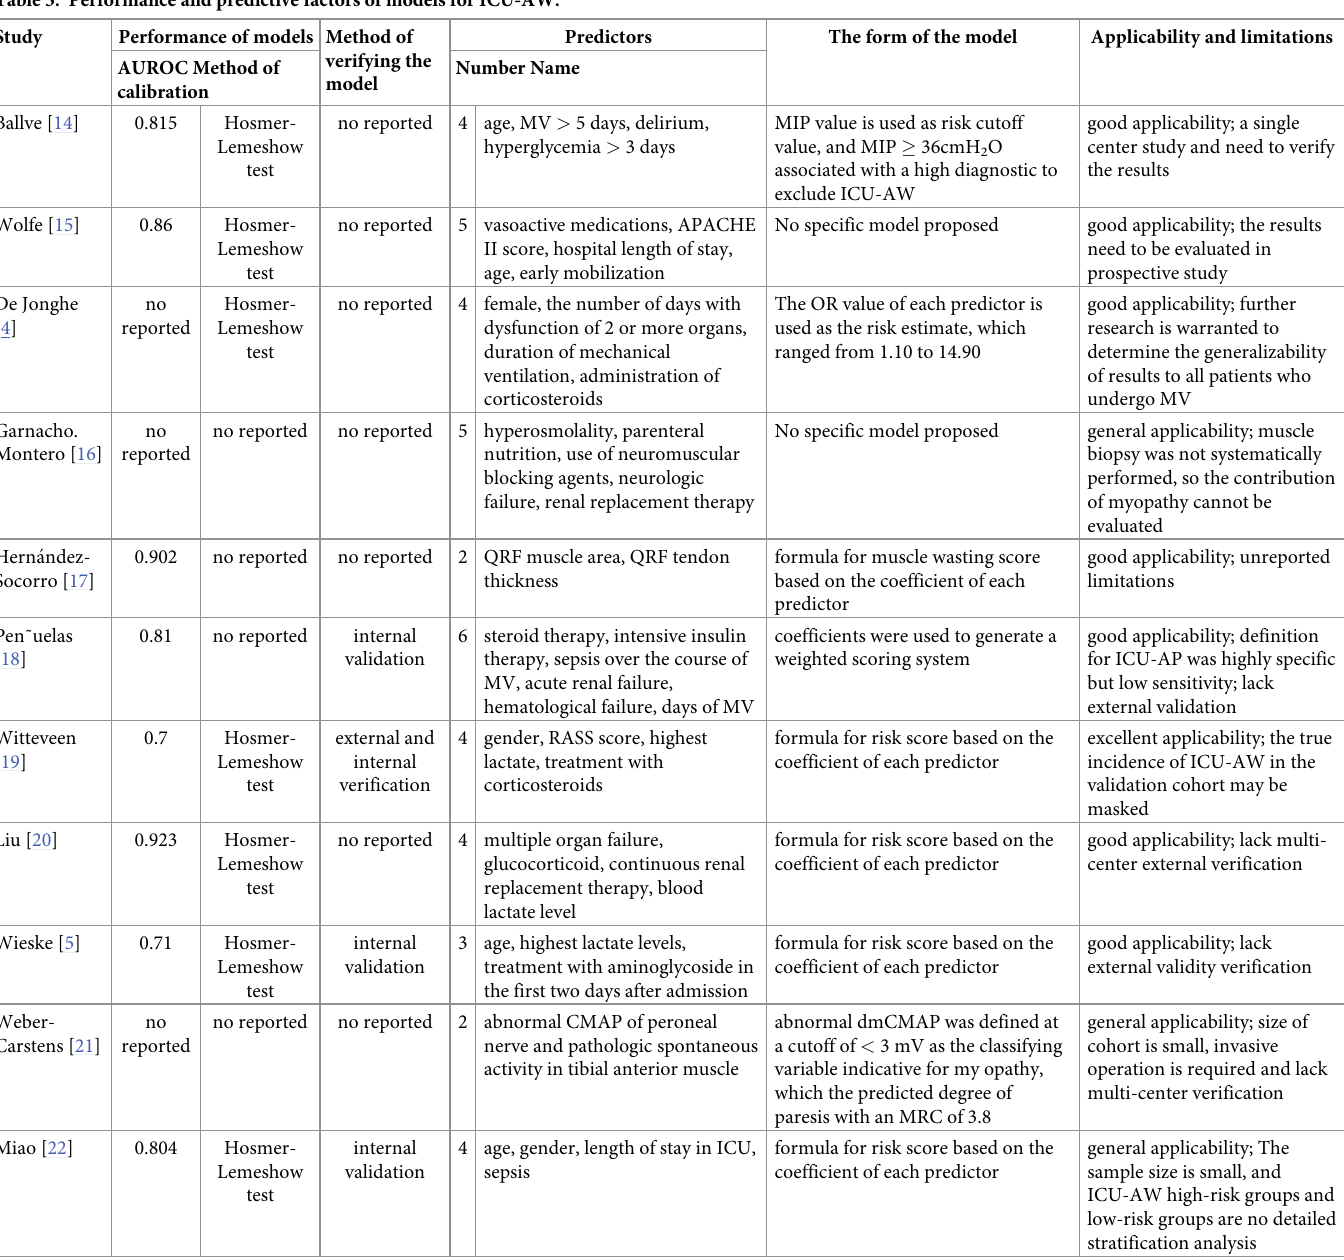
Table 3. Performance and predictive factors of models for